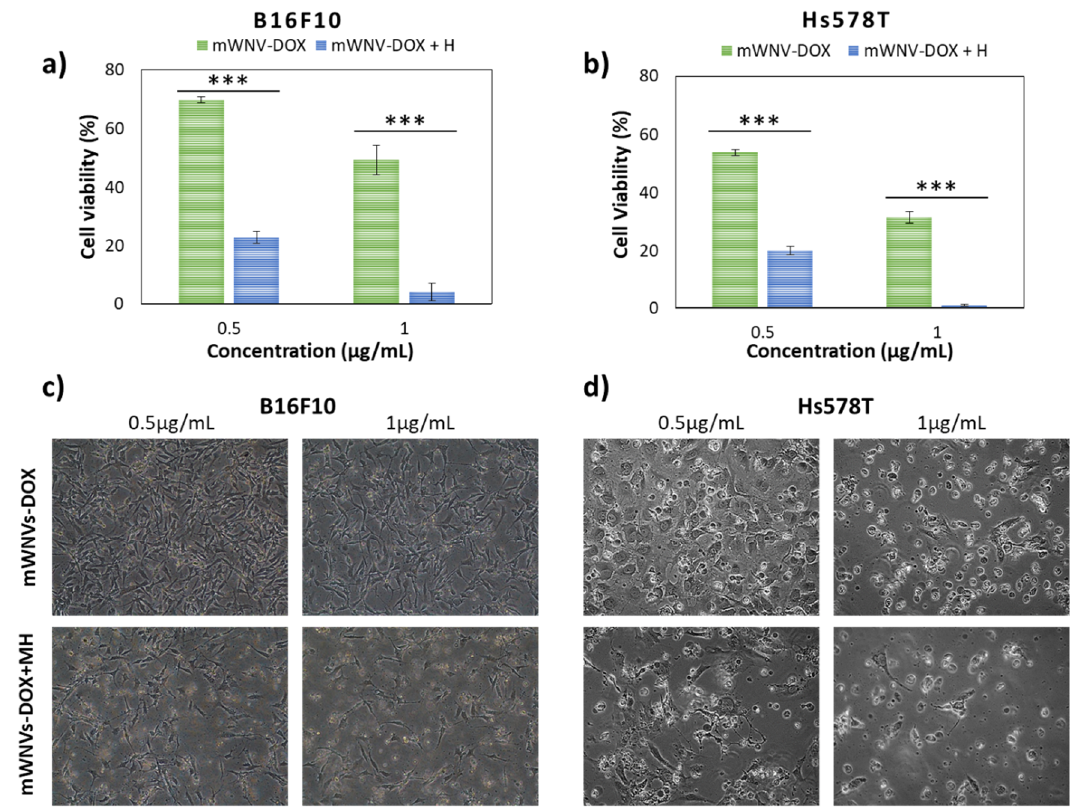
Figure 4. ( a ) B16F10 cell viability after exposure to 0.5 and 1 µg DOX/mL of mWNV-DOX, with (blue) and without (green) 1 h magnetic hyperthermia application. ( b ) Hs578T cell viability after exposure to 0.5 and 1 µg DOX/mL of mWNV-DOX with (blue) and without (green) 1 h magnetic hyperthermia application. The data represent the mean value ± SD of triplicate experiments; (***) statistical significance > 99.9% (Student’s t -test). Phase contrast images of B16F10 ( c ) and Hs578T ( d